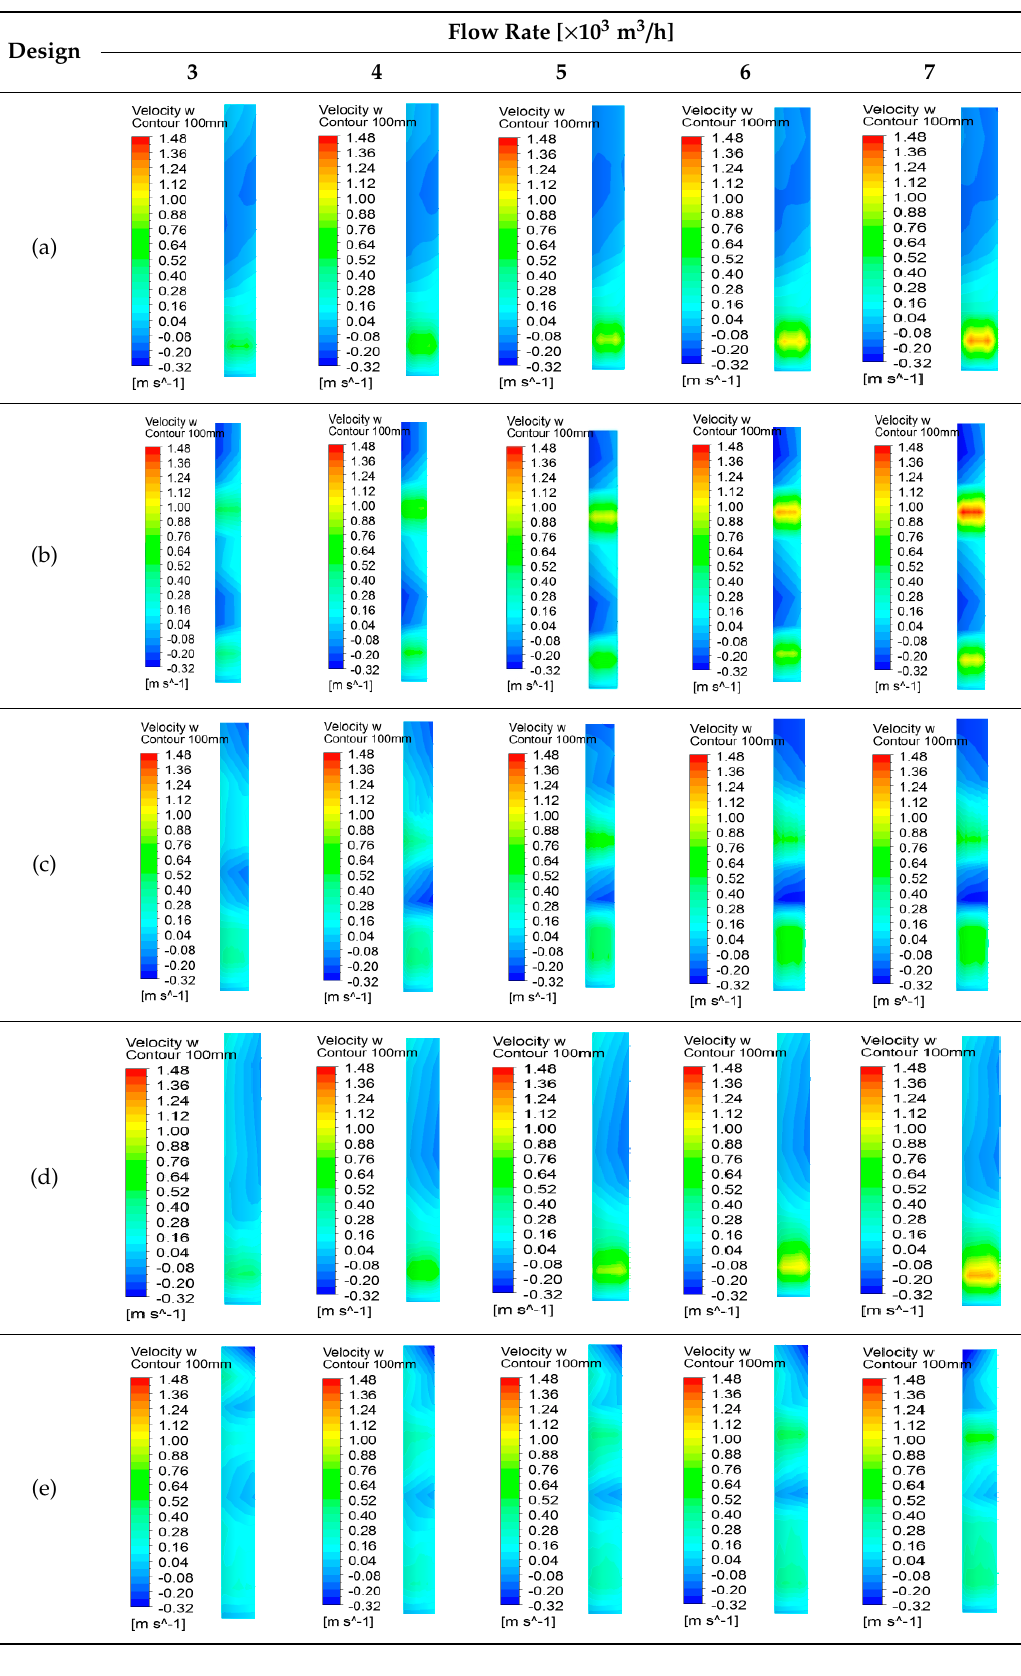
Table 1. Velocity distribution by the panel height for the different designs and flow rates.